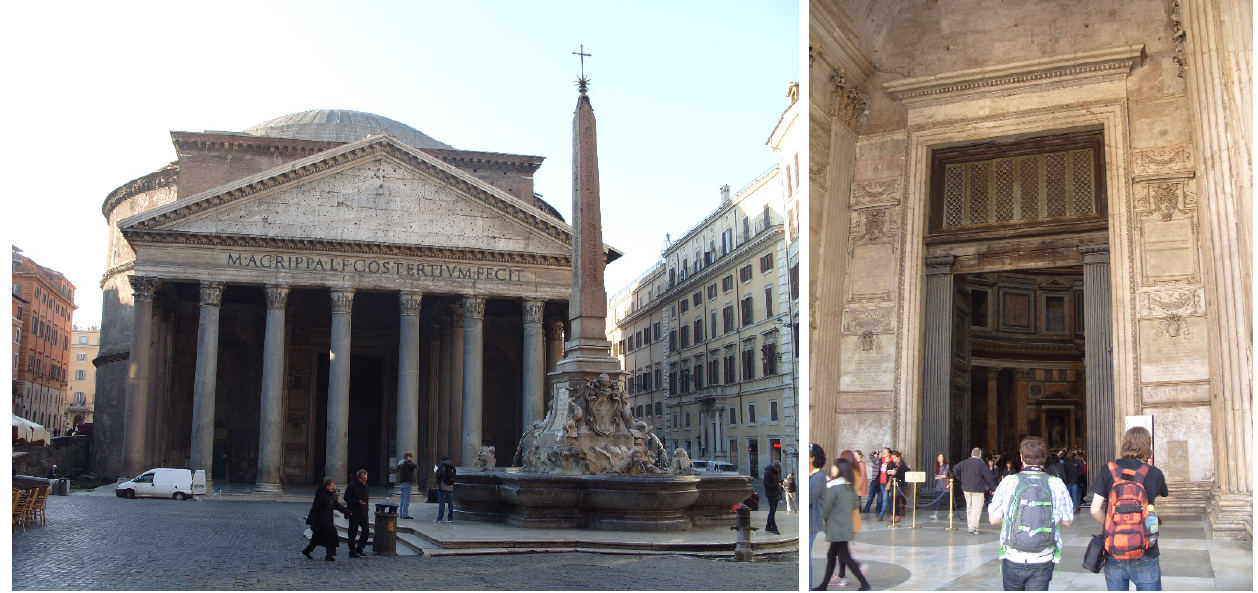
Figure 6. Whether the plaza in front of the Pantheon is experienced empty in the early morning or overcrowded with tourists, the standard temple front presents a theatrical stage set ( right ). The theatricality continues as individuals approach the massive bronze entry doors ( left ). Photographs by author.